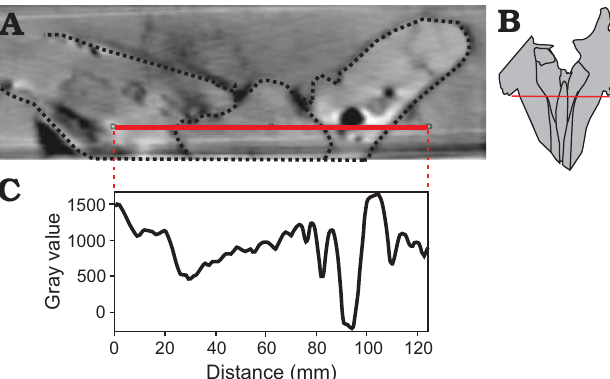
Fig. 8. CT-scan of the ziphiid cetacean Messapicetus cf. longirostris Bia- nucci, Landini, and Varola, 1992 skull (MDM-2029) inside two limestone slabs from the Tortonian of Menorca (Balearic Islands, Spain). A . Transverse section of the rostrum. B . Dorsal outline of the cranium showing the posi- tion of the section. C . Variation of the gray-value density along the trans- verse section of the